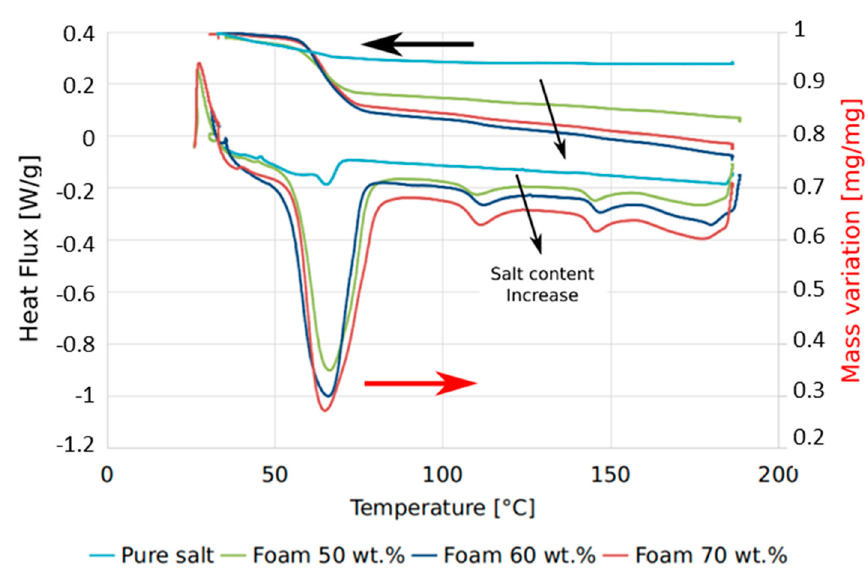
Figure 5. DSC measurement for three FOAM samples and the pure salt, under the same conditions (i.e., dehydration from 30 ◦ C to 180 ◦ C at 2.33 kPa and 5 K / min of heating (i.e., dehydration from 30 °C to 180 °C at 2.33 kPa and 5 K/min of heating rate).